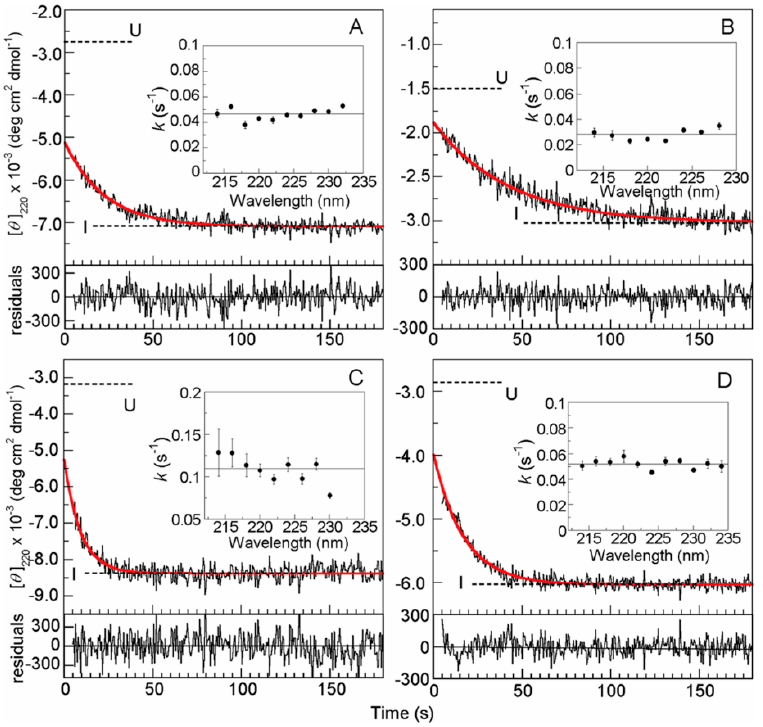
Figure 4. Representative plots of the [ θ ] at 220 nm during the U → I transitions at 25 °C for ( A ) equine β -lactoglobulin, ( B ) human tear lipocalin, ( C ) bovine α -lactalbumin, and ( D ) hen egg-white lysozyme in the gels. The times are those after initiation of the folding reaction. The thick red lines are each a fit Table 220 nm. The residuals are shown under each kinetic plot. The insets show the rate constants for the U → I phase calculated for each wavelength, with the horizontal lines being the average values. Reproduced with permission from [16].